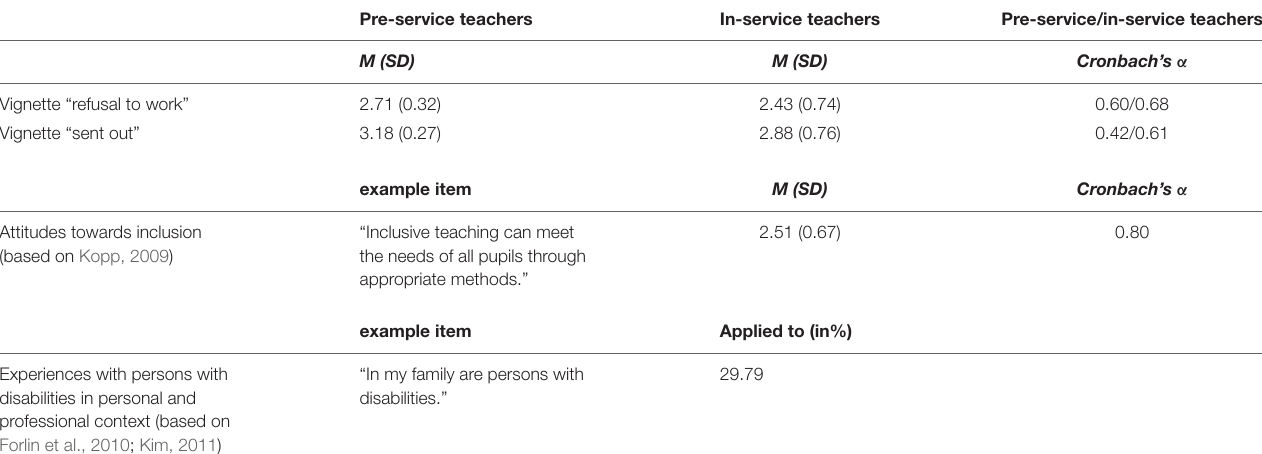
TABLE 2 | Descriptive statistics for the variables